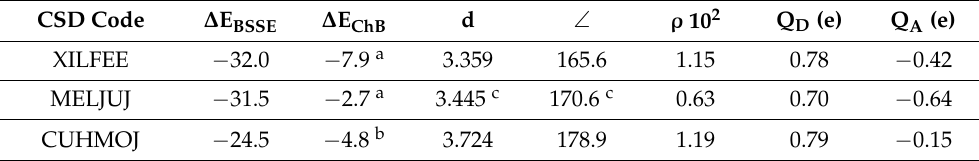
Table 4. Binding energies and the contribution of the Chalcogen bond contacts ( ∆ E BSSE and ∆ E ChB in kcal/mol, respectively), equilibrium distances (d, in Å), C–Ch ··· X (X = Cl, O and I), angle ( ∠ , in ◦ ) and value of the density at the bond critical point ( ρ 10 2 , in a.u.) for XILFEE, MELJUJ and CUHMOJ optimized dimers. The NBO charges of both chalcogen bond donor (Q D ) and acceptor (Q A ) atoms are also indicated in e. CSD Code ∆ E BSSE